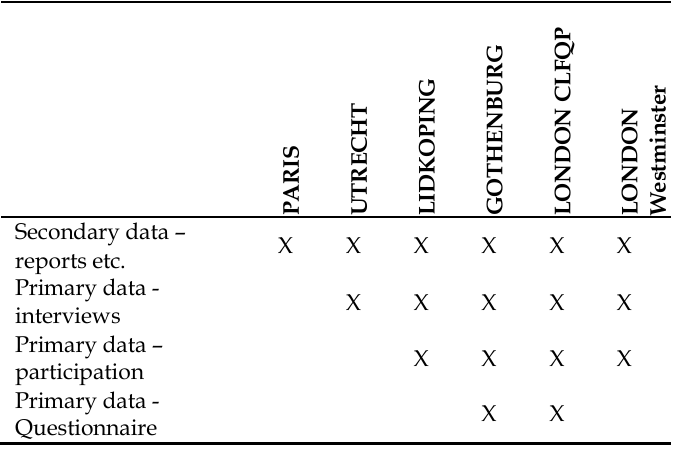
Table 1. Urban freight partnerships that have been